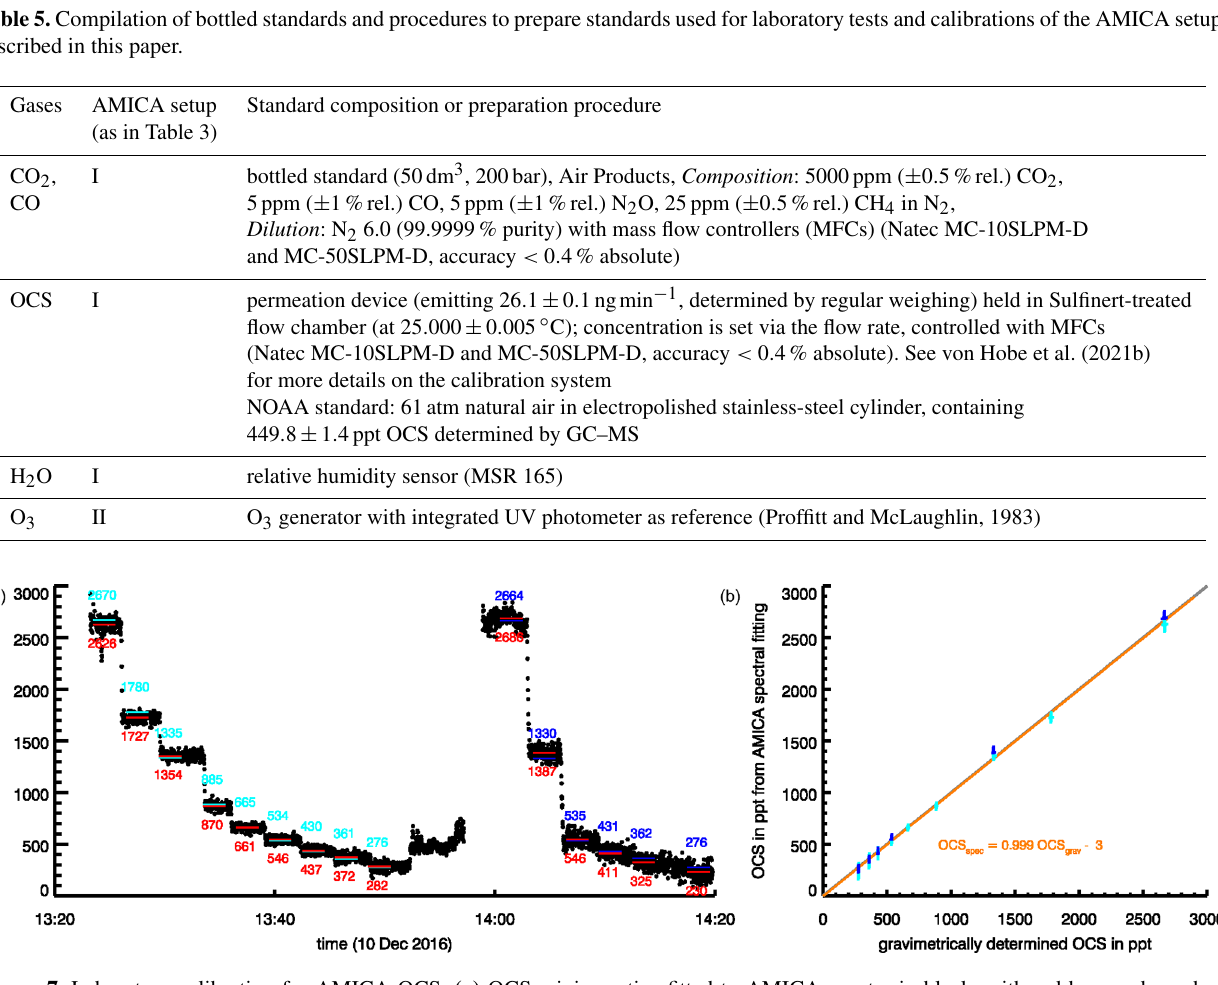
Figure 7. Laboratory calibration for AMICA OCS. (a) OCS mixing ratios fitted to AMICA spectra in black, with red bars and numbers indicating averages for each mixing ratio level. Mixing ratios of the standards are also shown as bars and numbers for a series at P cav = 46hPa (light blue) and one at P cav = 18hPa (dark blue). (b) Fitted AMICA OCS against the gravimetric standards with the same blue colours indicating P cav of each measurement. Error bars in x direction represent the uncertainty of the gravimetric standards (propagated from uncertainties in permeation rate and flow rates); error bars in y direction represent the statistic measurement uncertainty determined at each mixing ratio. The 1 : 1 line is shown in grey, and a linear fit to all data (independent of P cav ) is shown in